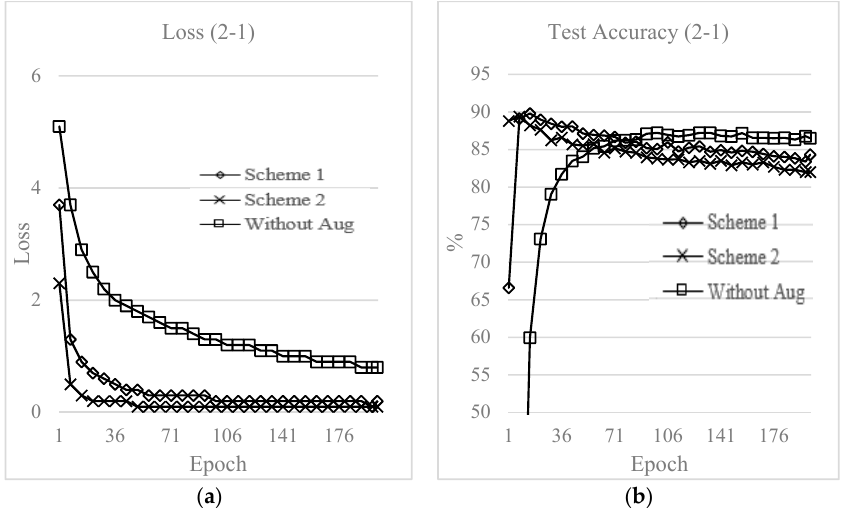
Figure 11. Lab simulation results. ( a , c ) Set 2 loss for the two cases. ( b , d ) Set 2 lab simulation test accuracy for the two cases.